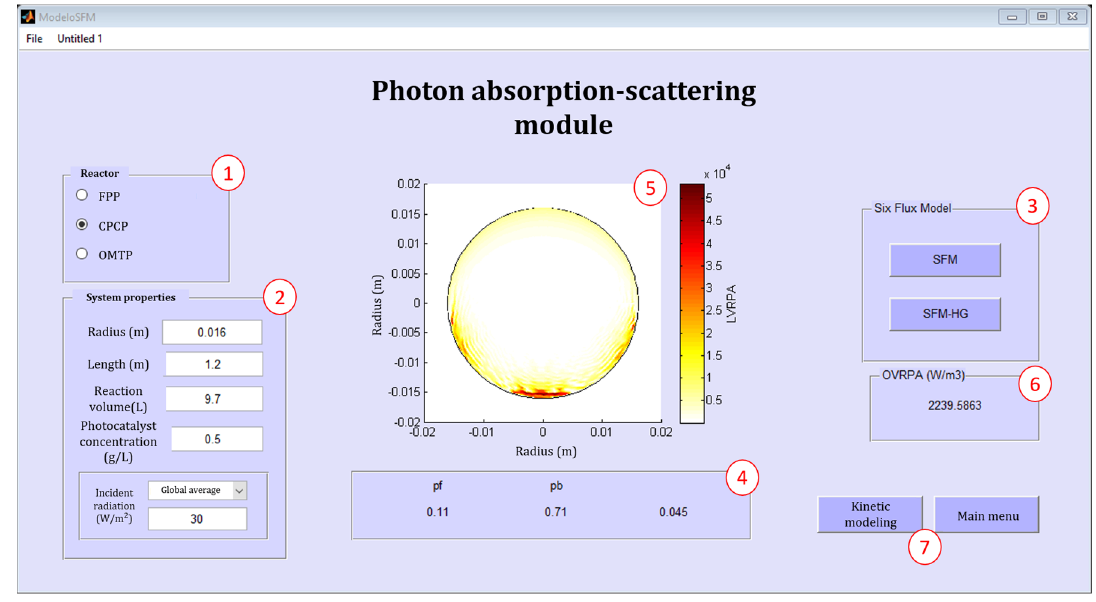
Figure 3. Radiation field simulation for a CPCP in the photon absorption-scattering module. (1) photoreactor panel; (2) system properties panel; (3) the SFM panel; (4) display the corresponding SFM scattering probabilities used in the simulation; (5) LVRPA spatial distribution plot; (6) OVRPA; (7) options menu.